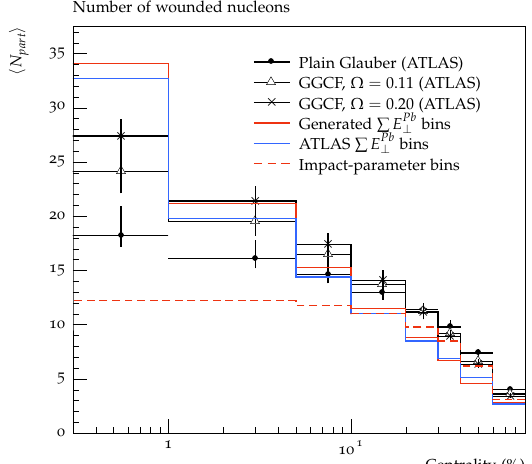
Figure 13 . Average number of wounded nucleons as a function centrality for pPb collisions at p s NN = 5 TeV. The point are taken from [26] where the numbers were calculated using three di(cid:11)erent Glauber calculations: (cid:12)lled circles used a standard calculation without (cid:13)uctuations, while triangles and crosses used the model in eq. (2.8) with (cid:13)uctuations controlled by (cid:10) = 0 : 11 and (cid:10) = 0 : 20 respectively. The solid lines are generated with Angantyr binned in generated (red) and experimental (blue) E Pb percentiles. The dashed line is also from Angantyr, but binned in ? impact-parameter P